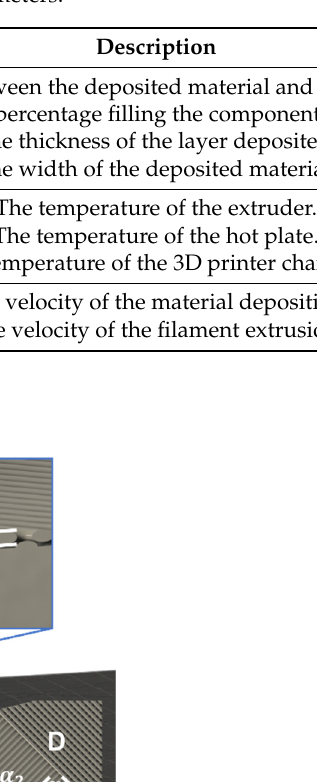
Figure 1. Tests and measurement of the product: ( a ) shapes and dimensions of the tensile sample; ( b ) measurement index to evaluate the warpage deformation; ( c ) warpage measurement methods based on the picture.